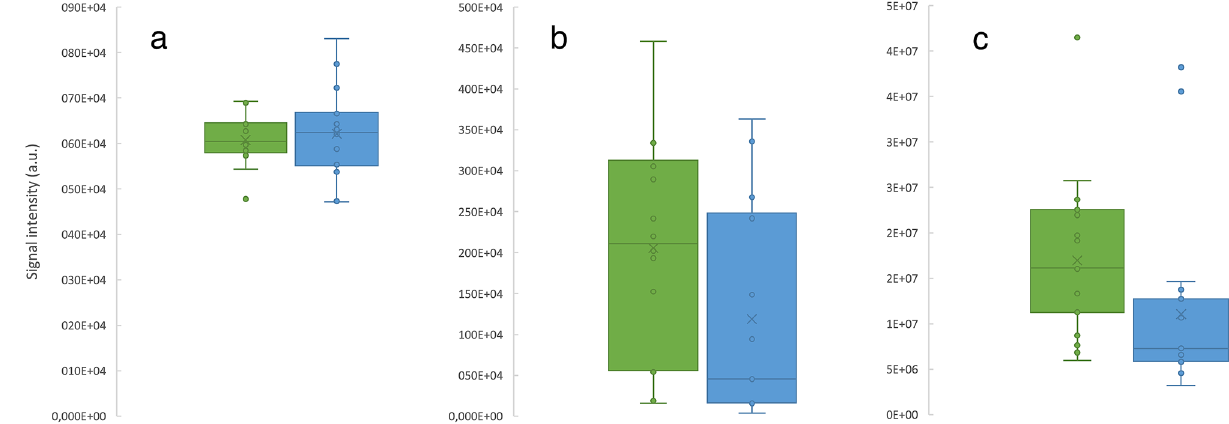
Figure 4. Boxplots representing signal intensities of significantly (p < 0.05) altered metabolites in patient groups with (green, n = 19) and without (blue, n = 18) history of Hirschsprung-associated enterocolitis for ethyl pentyl